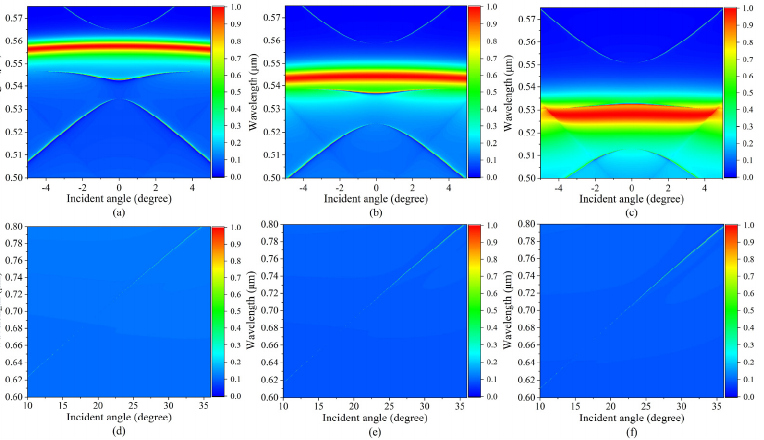
Figure 8. Re fl ectance spectra of the metasurface around at Γ BICs with side length ( a ) W 1 = W 2 = 0.1 µm, ( b ) W 1 = W 2 = 0.125 µm, and ( c ) W 1 = W 2 = 0.15 µm, respectively, and around o ff Γ BIC with side length ( d ) W 1 = W 2 = 0.1 µm, ( e ) W 1 = W 2 = 0.125 µm, and ( f ) W 1 = W 2 = 0.15 µm, respectively. a = 0.336 µm, and L 1 = L 2 = 0.1 µm.